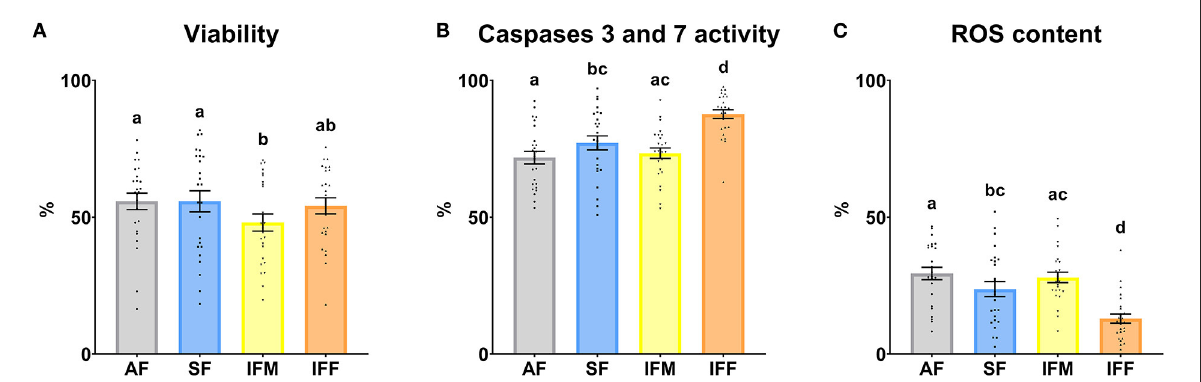
FIGURE7 Ram sperm functionality according to ejaculate collection frequencies. (A) Viability, Zombie Violet TM (%); (B) Caspases 3 and 7 activity, CellEvent TM Caspase-3/7 Green (%); (C) ROS content, CellROX TM Deep Red (%). The same 25 males were analyzed in each experimental group (AF, abstinence semen collection frequency; SF, standard semen collection frequency; IFM, intensive semen collection frequency on Monday; and IFF, intensive semen collection frequency on Friday). Graph dots represent individual male values. Means ( ± SEM) are shown. Different lowercase superscripts letters (a–d) indicate differences ( P ≤ 0.05) among the semen collection frequencies.